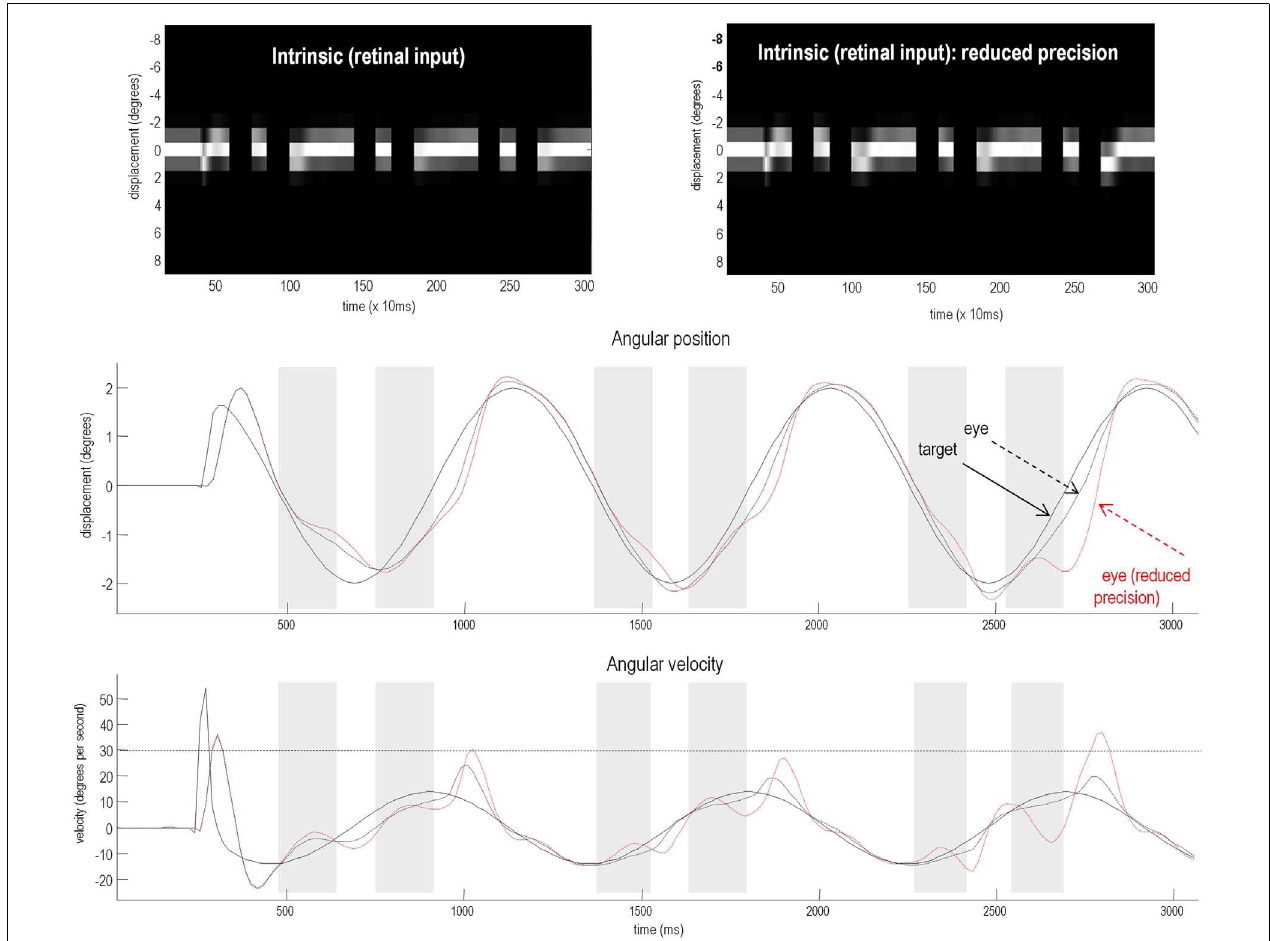
of peristimulus time.They illustrate the remarkably accurate tracking behavior that is produced by prior beliefs that the center of gaze and target are drawn to the same fictive point – beliefs that action fulfils.The gray area corresponds to the period of visual occlusion.The upper right panel shows sensory input when the precision of prediction errors on the motion of hidden states at the second level was reduced from a log precision of − 1 to − 1.25.The associated behavior is shown with red broken lines in the lower panels.The dashed horizontal line in the lower panel corresponds to an angular velocity (30°); at which the eye movement would be considered saccadic.This simulation illustrates the loss of Bayes-optimal tracking when the motion of the target corresponds to high-level posterior beliefs but the precision of these beliefs is